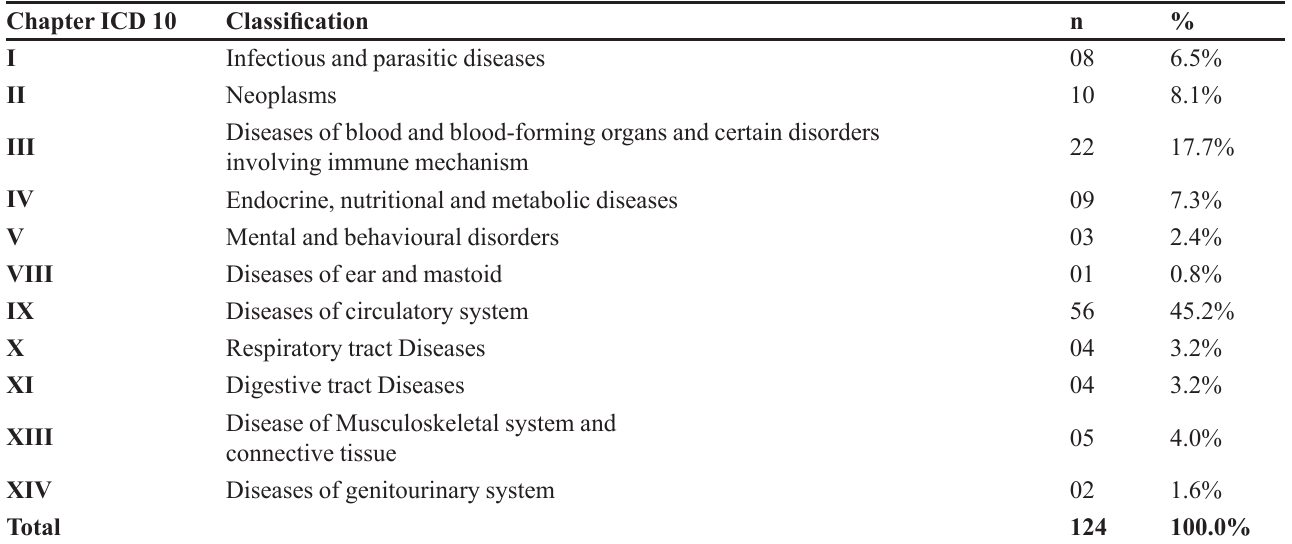
TABLE III - Classification of 124 active diagnoses according to chapters of ICD